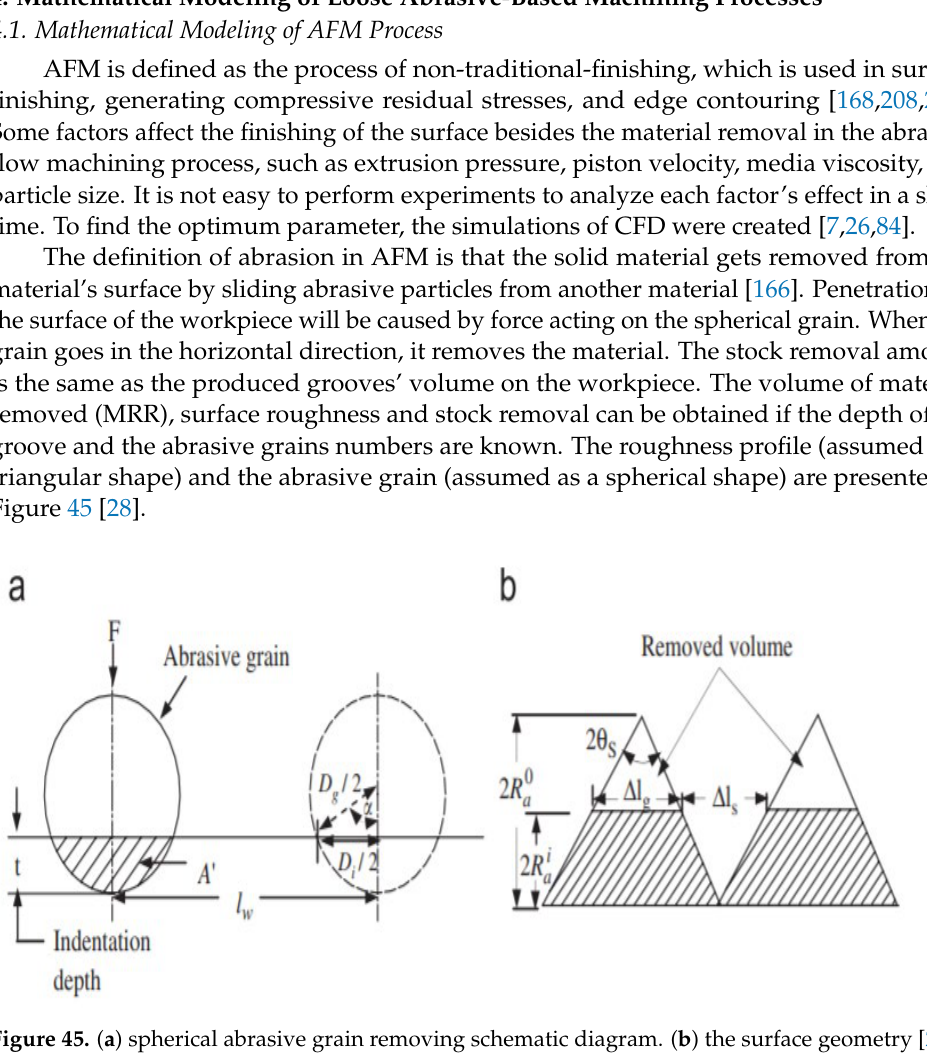
Table 14. The validation of the CFD tool